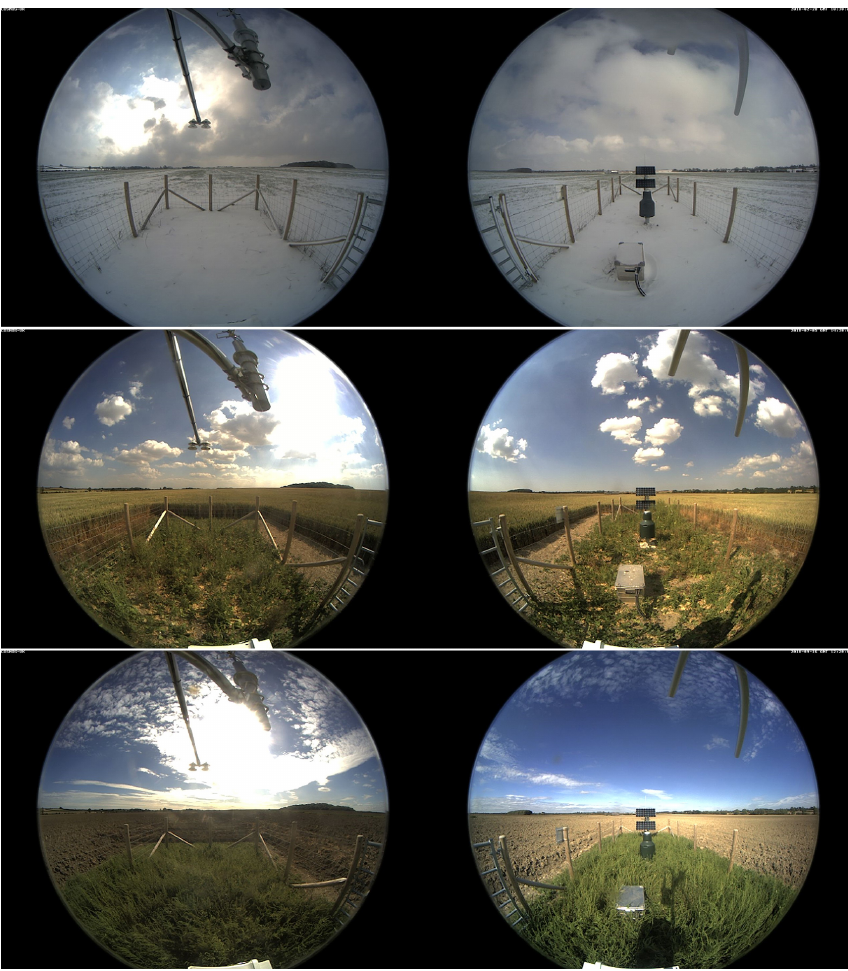
Figure 9. PhenoCam photographs from the Fincham COSMOS-UK site in East Anglia. From top: a snow event at the end of February 2018, rapeseed oil crop growing in surrounding field in July 2018, and the bare field in September